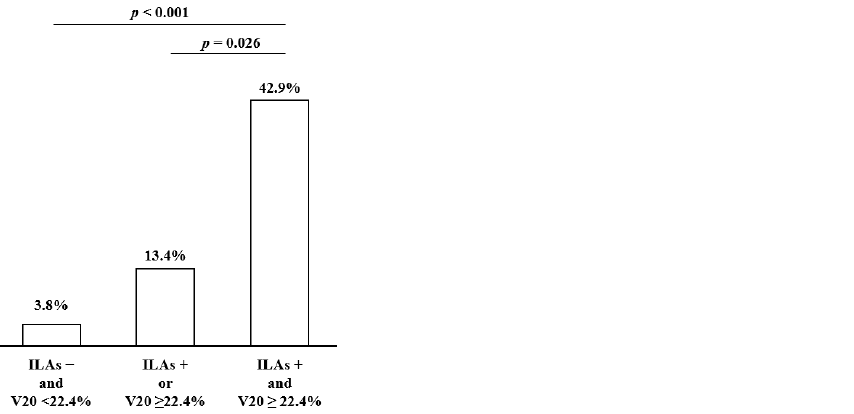
Figure 2. Incidence of early onset grade ≥ 2 ILD. Incidence of early onset grade ≥ 2 ILD in patients with ILAs and higher V20 was significantly higher than those with ILAs or higher V20 (42.9% vs. 13.4%, p = 0.0026) and those without ILAs and with lower V20 (42.9% vs. 3.8%, p < 0.001). ILAs, interstitial lung abnormalities; V20, volume of lung parenchyma that received ≥ 20 Gy; ILD, intersti- tial lung disease.